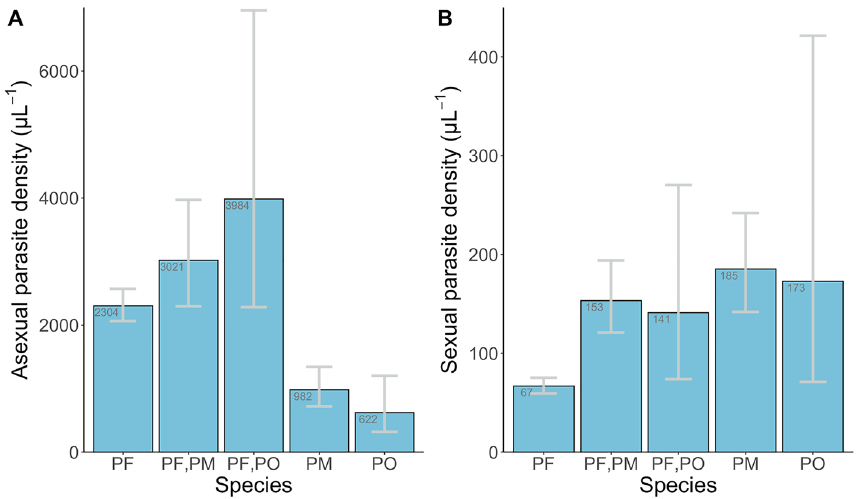
Figure 4. Geometric means (with 95% CIs) of asexual and sexual parasite densities for different Plasmodium species and co-infections in Nigeria (PF, P. falciparum ; PM, P. malariae ; PO, P. ovale ; no slide was positive for P. vivax ). Sample sizes (numbers of infections with asexual parasites counted) for the asexual density measurements were 1450, 109, 24, 71 and 19 (for PF, PF/PM, PF/PO, PM and PO respectively). Sample sizes (numbers of infections with sexual parasites counted) for the sexual density measurements was 472, 61, 15, 45 and 11 (for PF, PF/PM, PF/PO, PM and 19